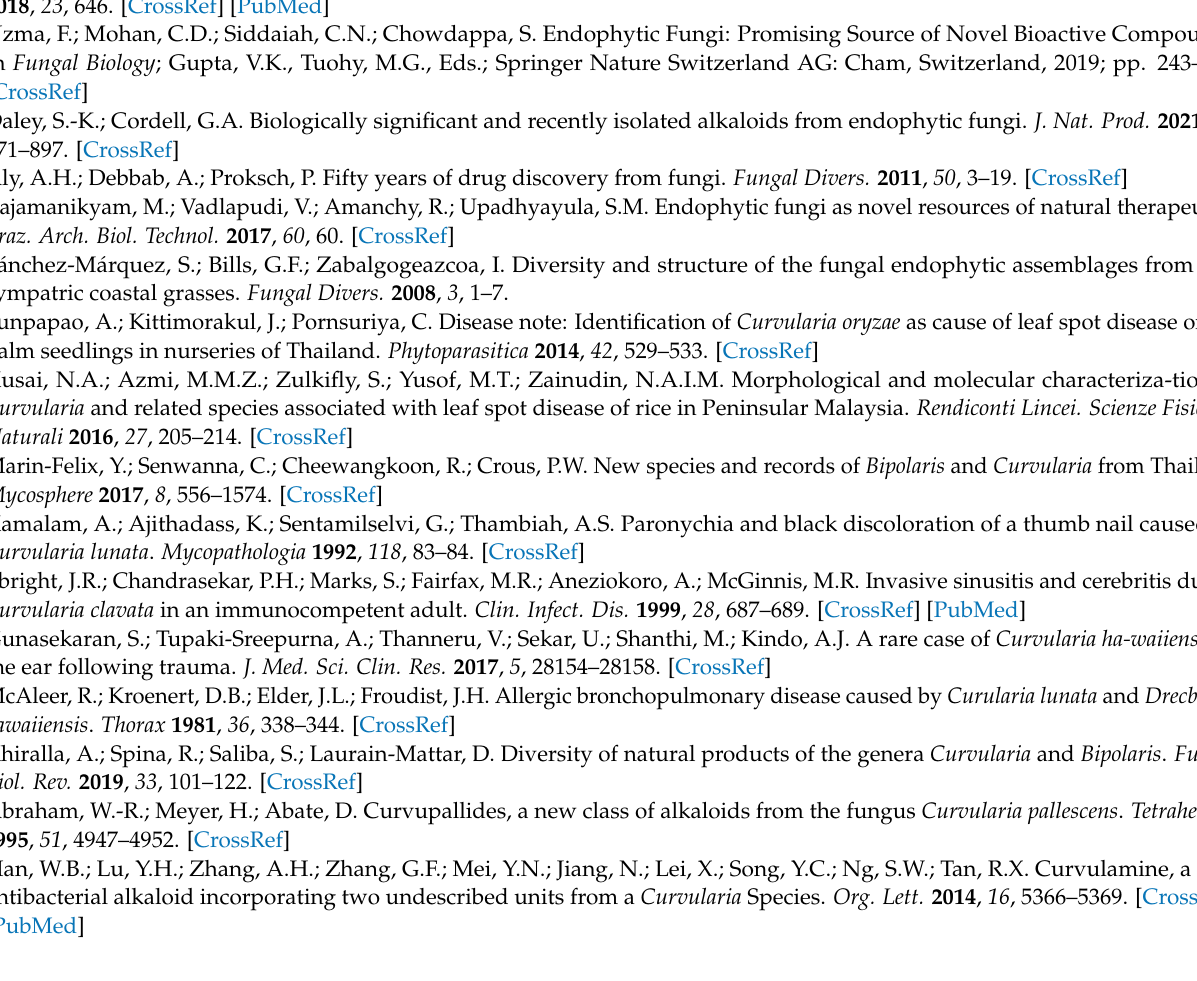
6 , Figure S17: 13 C NMR (100 MHz, CDCl 3 ) of compound 6 , Figure S18. Optimized structures of compounds 5 a- 5 f using B3LYP/6-31G(d,p) level in methanol (PCM). Figure S19. ECD spectra of compounds 5 a- 5 f compare with experimental ECD compound 5